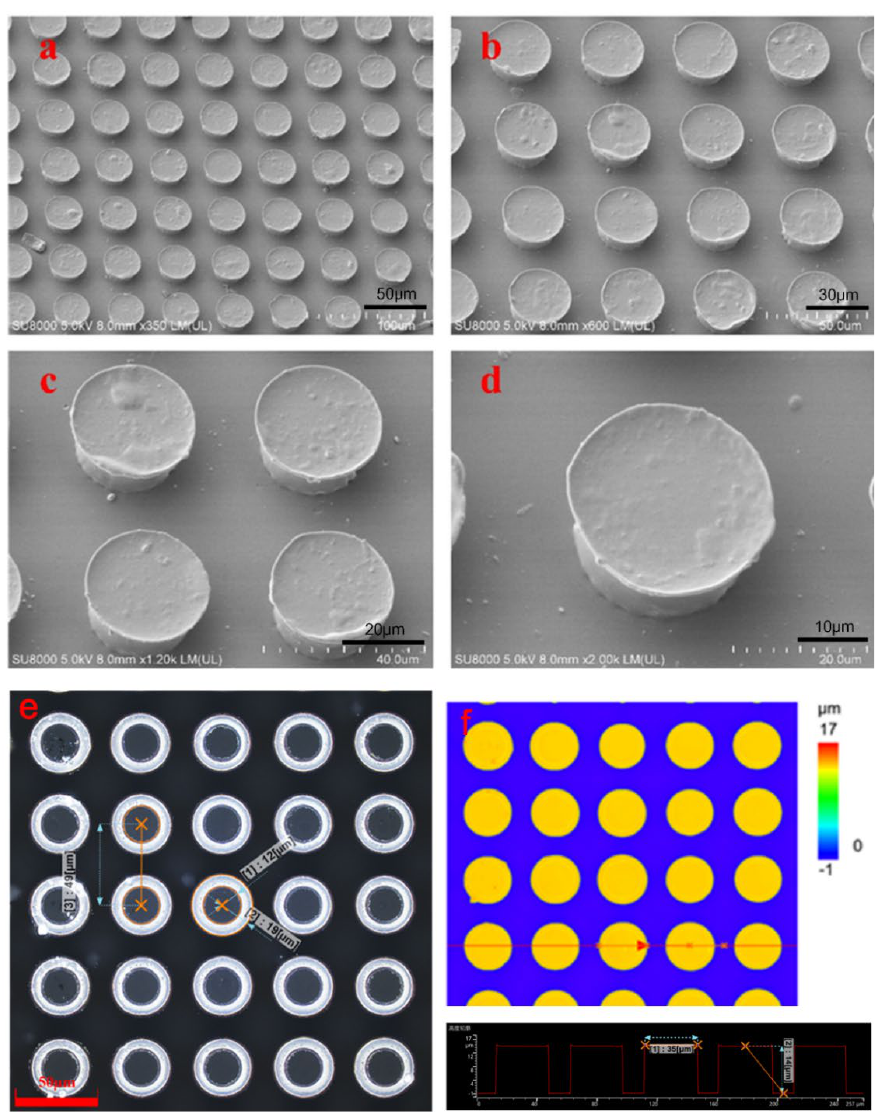
Figure 4. Morphological characterization of the dry adhesive microstructures. ( a )-( d ) Different magnified SEM images of the 20 μm sample. ( e ) Confocal microscope image showing the diameter of the head and pillar, and the distance between adjacent mushroom structures. ( f ) Confocal microscope image indicating the profile and height of the mushroom structures.